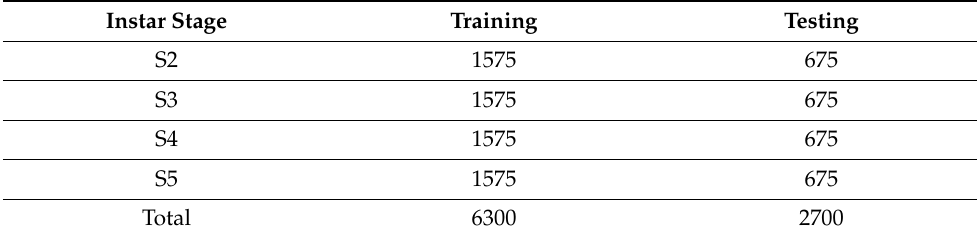
Table 2. Number of training and testing images for each instar